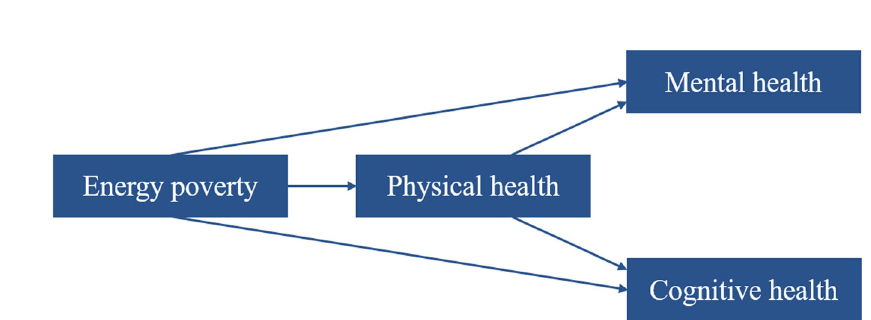
Fig. 1 Mechanism diagram. The mechanism of the impact of EPOV on the health of middle-aged and older